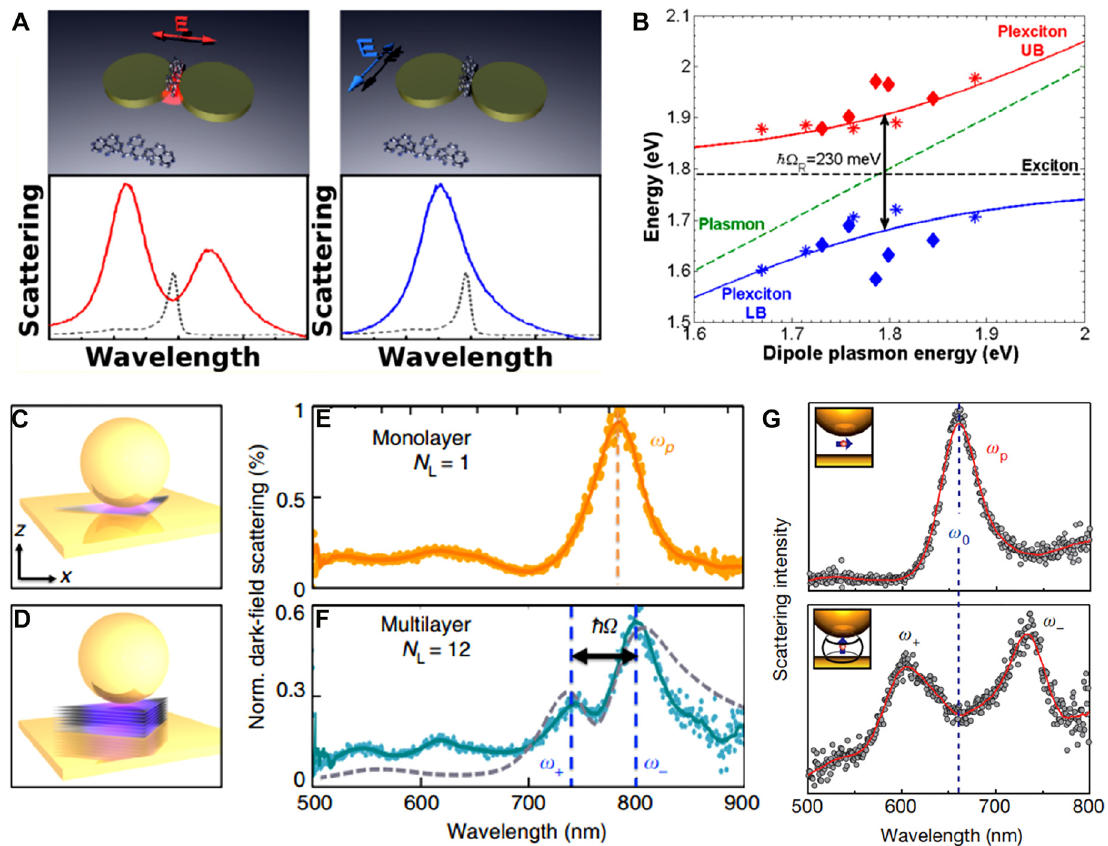
Figure 18: Strong coupling and Rabi splitting in nanogaps. (A) and (B) Strong coupling between plasmons in metallic nanodimers and excitons in J-aggregates leading to a formation of plexcitons and Rabi splitting of 230 meV. (C) – (F) Nanoparticle-on-a-mirror geometry with monolayer (C) and multilayer (D) WSe 2 exhibiting no coupling (E) and strong coupling(F),respectively.GStrongcouplingofdyemoleculeswithgapplasmonmode,occurringonlywhenthetransitiondipolemomentofthedye molecules aligns with the enhanced electric fi eld at the gap. Reproduced with permission from [211] (A) and (B) [30], (C) – (F) [212],